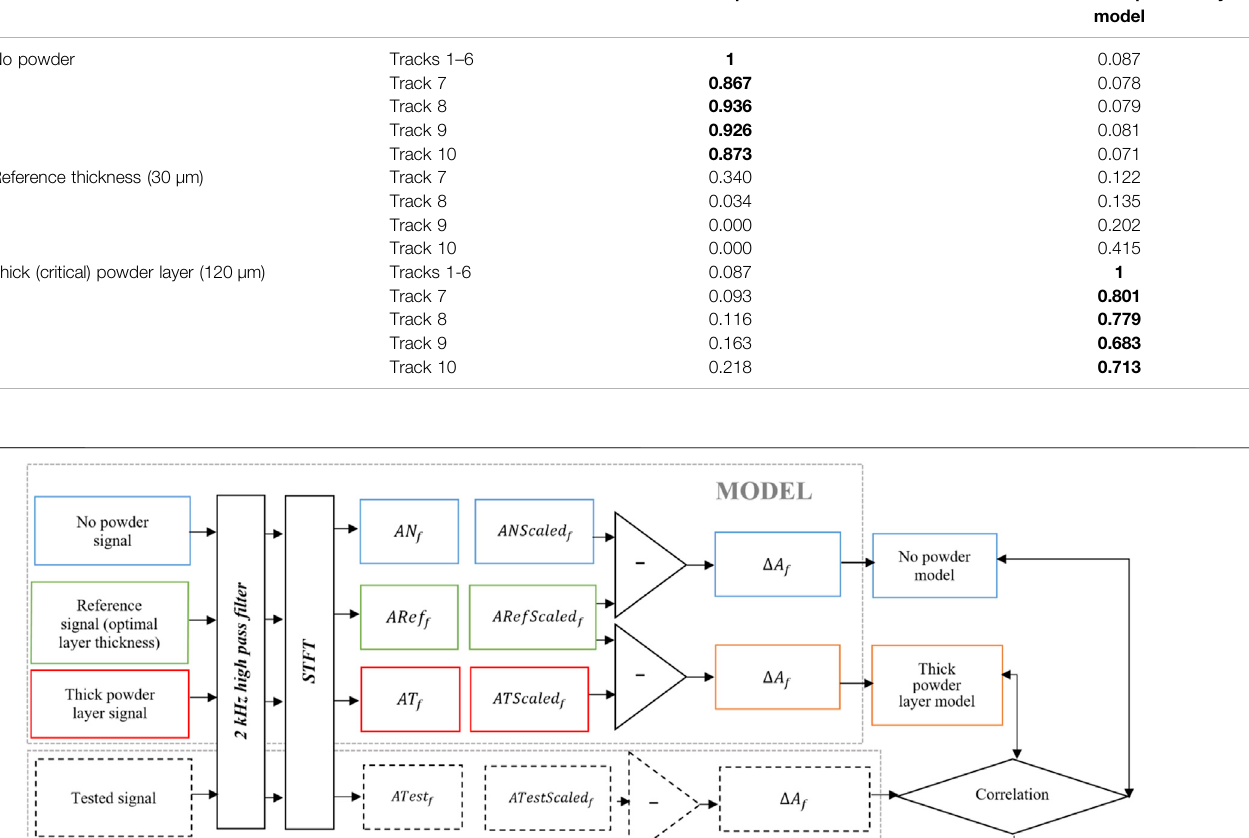
“ Reference — no powder ” model “ Reference – thick powder layer ” model